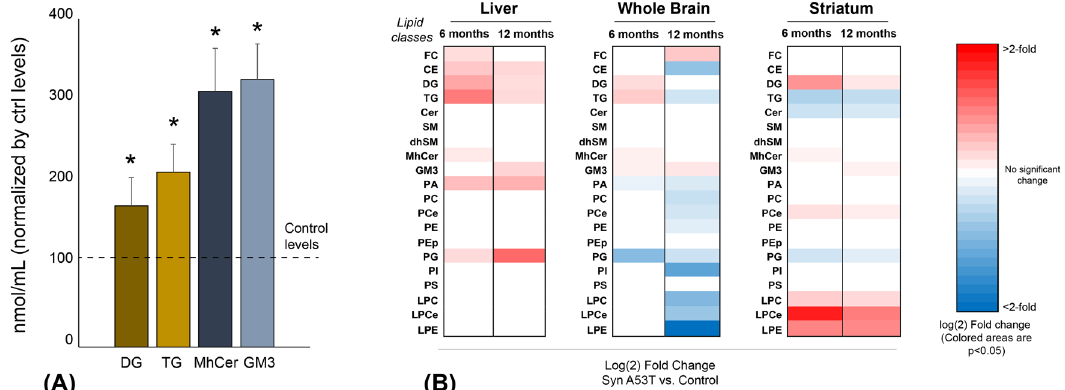
Fig. 3 Changes in lipid classes in SNCA G209A cells and transgenic mice. a Elevations in diradylglycerol (DG), triradylglycerol (TG), monohexosylceramide (MhCer), and monosialodihexosylganglioside (GM3) classes in homogenates from SNCA G209A neuroblastoma cells versus control lines ( n = 4 biological replicates ± SD each run in triplicates. * p < 0.05, t test); b heatmaps representing statistically signi fi cant changes [log (2) fold change mutant versus controls] in main classes of lipids in tissues from SNCA G209A transgenic mice versus tissues from SNCA transgenic and non-transgenic mice ( n = 3 biological replicates each run in triplicates. Colored areas are p < 0.05. t test. CI